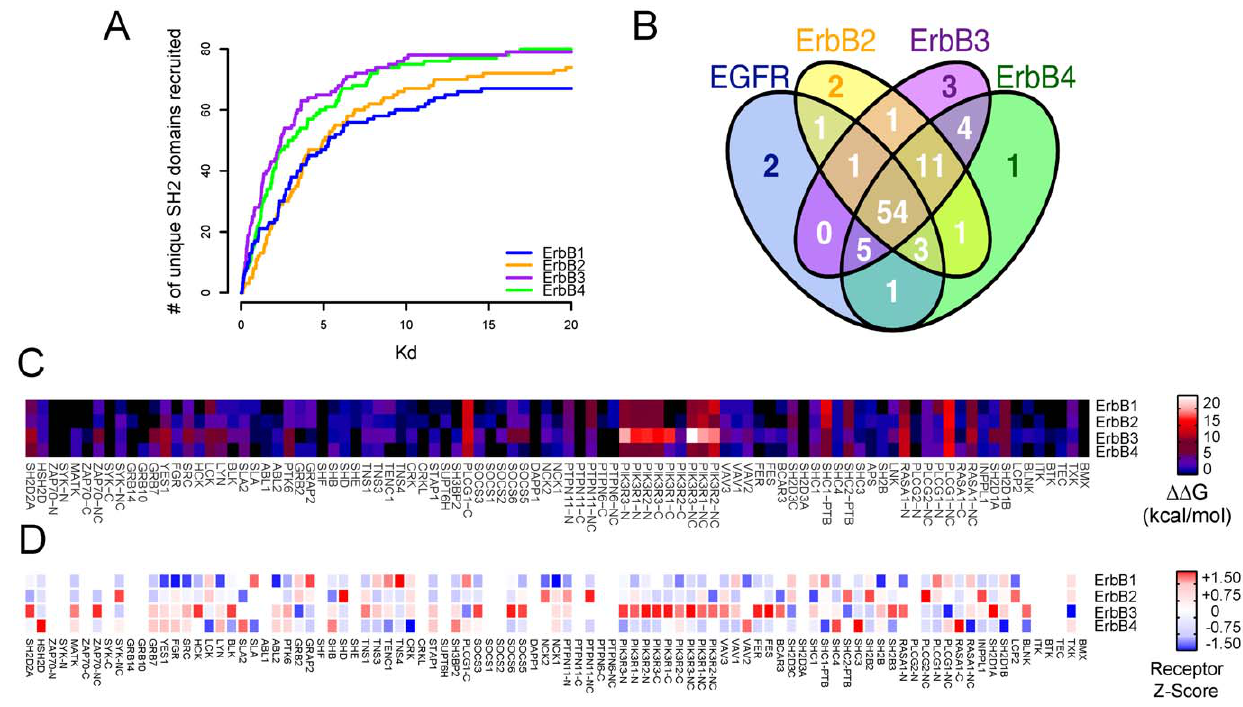
Figure 5. Characterization of unique and overlapping SH2 domain recruitment patterns by individual ErbB receptors. ( A ) SH2 recruitment potential of ErbB1 family members at different affinity thresholds. The total number of unique SH2 and PTB domains recruited over a range of affinity thresholds are depicted for each receptor. ( B ) Four-way Venn diagram (not to scale) depicts SH2 domain interactions shared by or exclusive to ErbB1, ErbB2, ErbB3, and ErbB4. ( C ) Relative binding free energies of interactions described in Figure 2 are summed for each ErbB receptor. ( D ) Relative enrichment and depletion of binding sites for recruitment of each SH2 domain by each ErbB receptor, depicted by Z-score transforming the observed number of binding sites each receptor had for a particular domain relative to the average number of sites that bound that domain across all ErbB receptors. Domains recruited by fewer than four independent pY sites were excluded from this analysis.